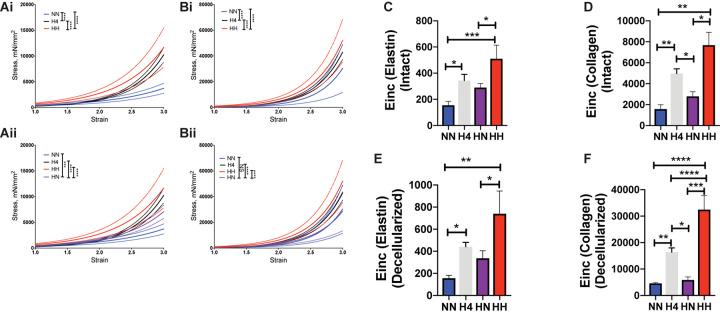
Hypertension causes aortic stiffening that is partially reversed by restoration of blood pressure. Tensile testing of (Ai,ii) intact aortas and (Bi,ii) decellularized aortas (n = 7 mice per group). Data are shown as mean (solid line) ± standard error of the mean (dotted lines of same color). ∗∗∗p < 0.001, ****p < 0.0001 by ordinary 2-way ANOVA with Bonferroni post hoc analysis for AngII status and strain. Incremental elastic modulus (Einc) of (C) intact vessels at low strain of 0.5 representing elastin deformation; (D) intact vessels at high strain of 1.8 representing collagen deformation; (E) decellularized vessels at low strain of 0.5 representing elastin deformation; (F) decellularized vessels at high strain of 1.8 representing collagen deformation. n = 7 mice per group, ∗p < 0.05, ∗∗p < 0.01, ∗∗∗p < 0.001, ****p < 0.0001 by ordinary 1-way ANOVA with Bonferroni post hoc analysis.